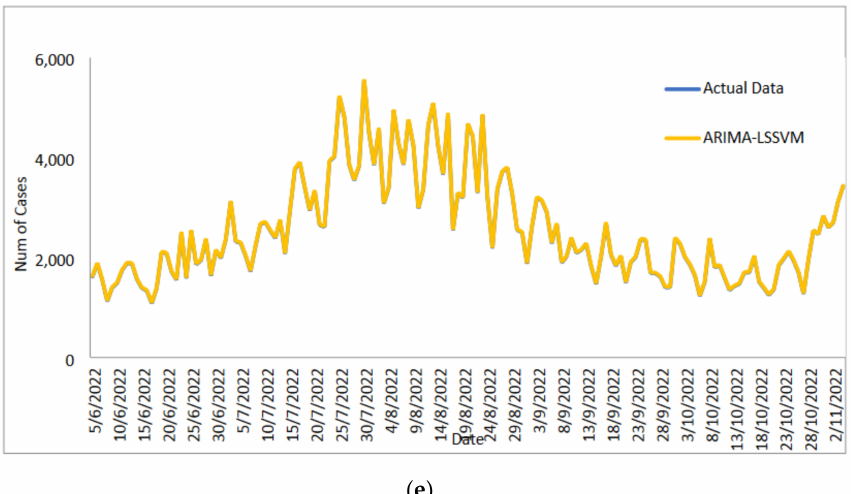
Figure 12. Models’ prediction of daily new recovered COVID-19 cases dataset (20% test sample): ( a ) actual data vs. ARIMA model, ( b ) actual data vs. SVM model, ( c ) actual data vs. LSSVM models, ( d ) actual data vs. ARIMA–SVM models, ( e ) actual data vs. ARIMA–LSSVM